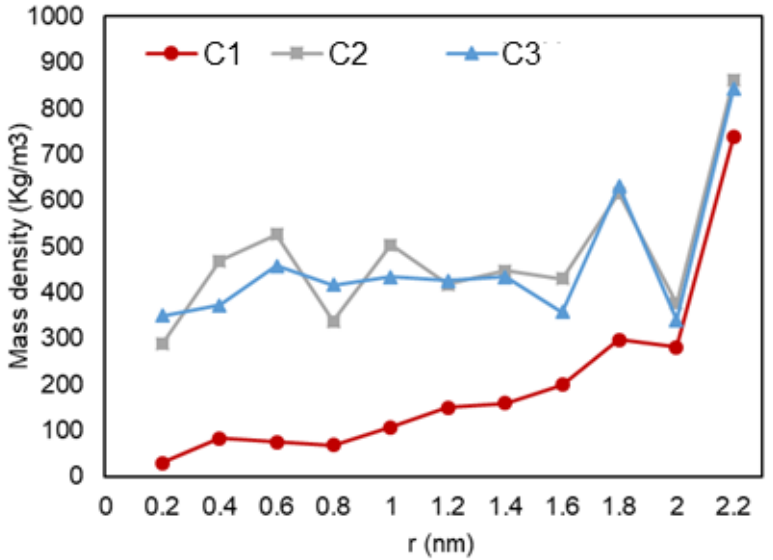
Figure 12. Mass density vs. radial position in C1 (gas phase in bulk), C2 (two-phase in bulk), and C3 (liquid phase in bulk) conditions.